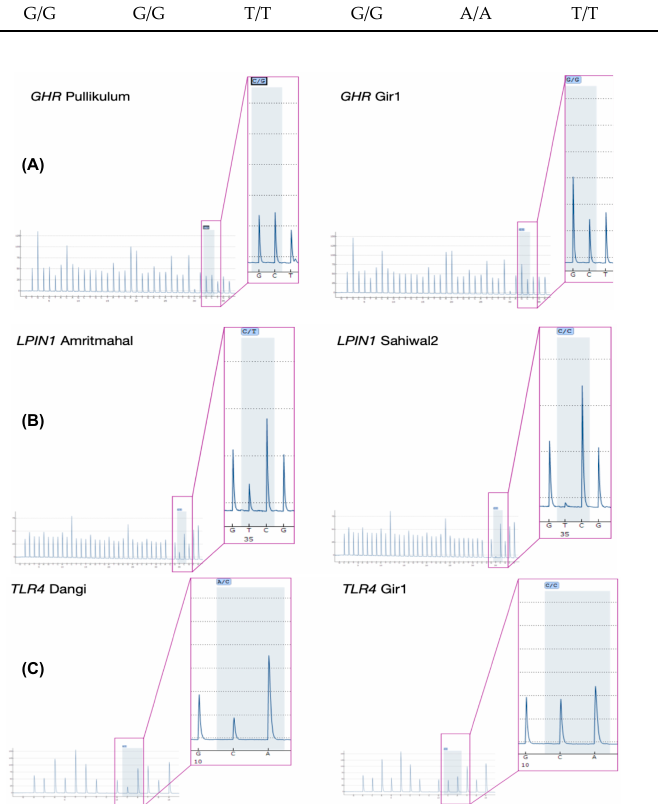
Figure 3. Confirmation of mutations shown in pyrograms with PyroMark SNP analysis assays: ( A ) GHR Gy392Ala (C>G) in Pulikulam (low-milk-yield breed) and (C/C) in Gir (high-milk-yield breed); ( B ) LPIN1 a Arg772Lys (G>A) in Amritmahal (low-milk-yield breed) and (G/G) in Sahiwal (high-milk-yield breed); ( C ) TLR4 a Asn347Gly (A>C) in Dangi (low-milk-yield breed) and (C/C) in Gir (high-milk-yield breed); the pyroseq sequencing primer is in reverse.